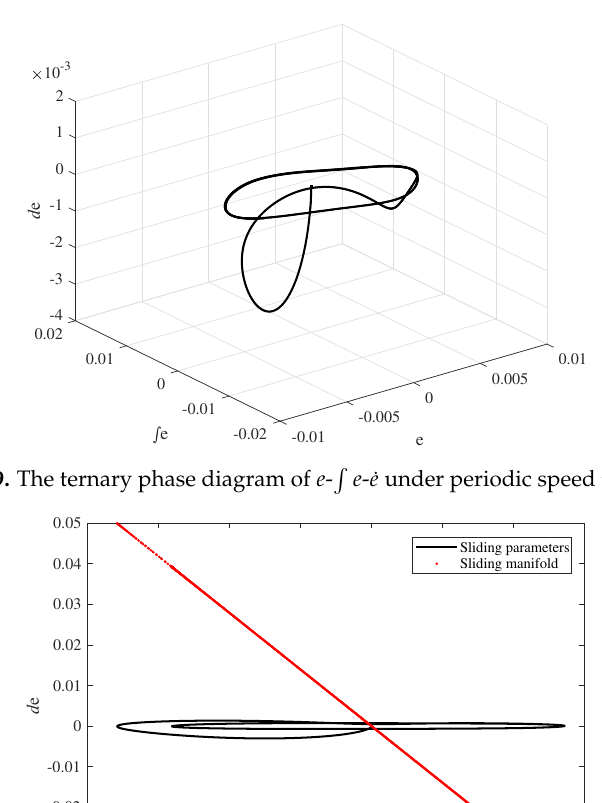
Figure 8. The ternary phase diagrams of y 1 - x t - h regulated by ( a ) SMC and ( b ) PSO-PID under periodic speed tracking.